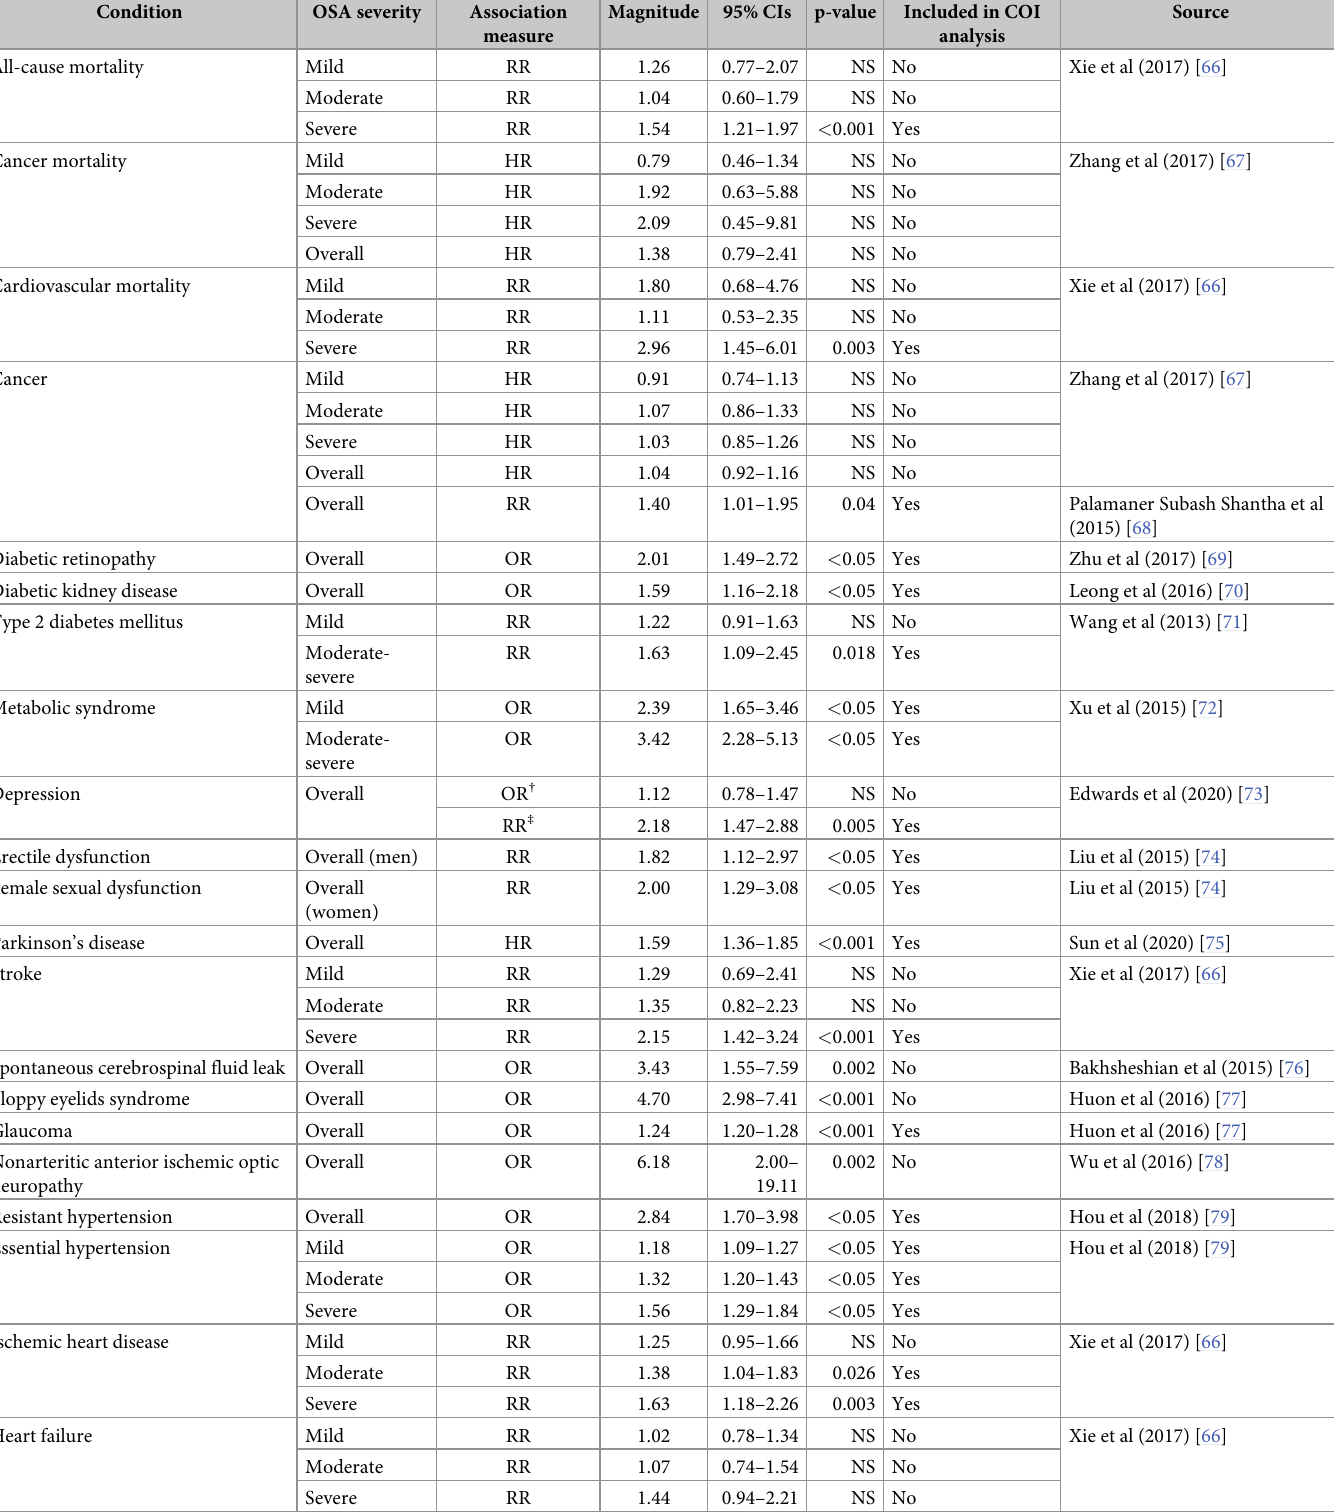
Table 2. Results of systematic literature review: Association between OSA and other